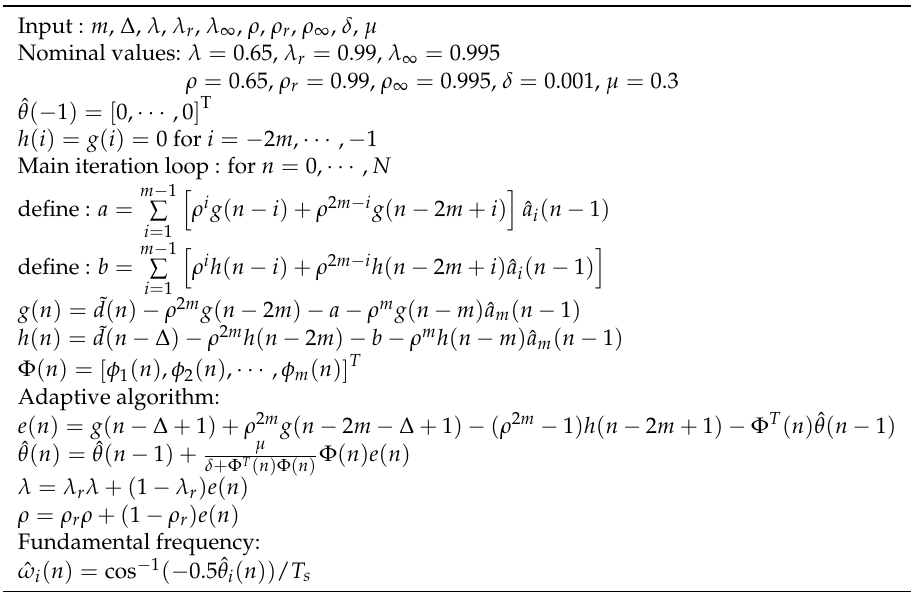
Figure 11. Frequency characteristics of SOGI with respect to parameter b p : ( a ) magnitude; ( b ) phase. Table 1. Adaptive notch filter (ANF) multi-frequency estimation algorithm based on SM method